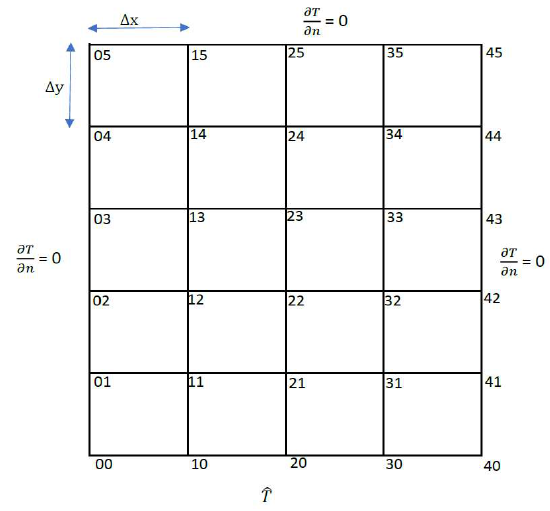
Figure A1. The grid used for the finite difference. For the interior nodes